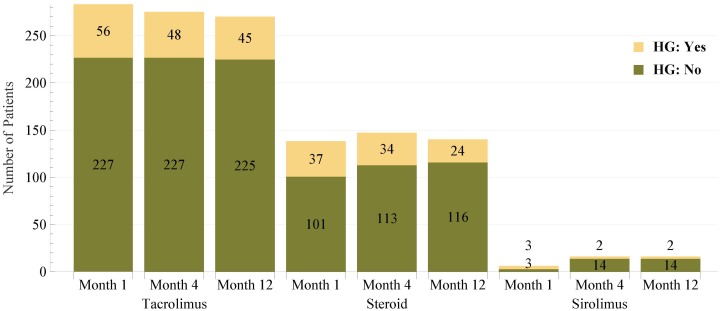
Number of patients who used immunosuppressive drugs at months 1, 4, and 12.Such patients are further classified as having hyperglycemia (HG) or not at that specific time points.